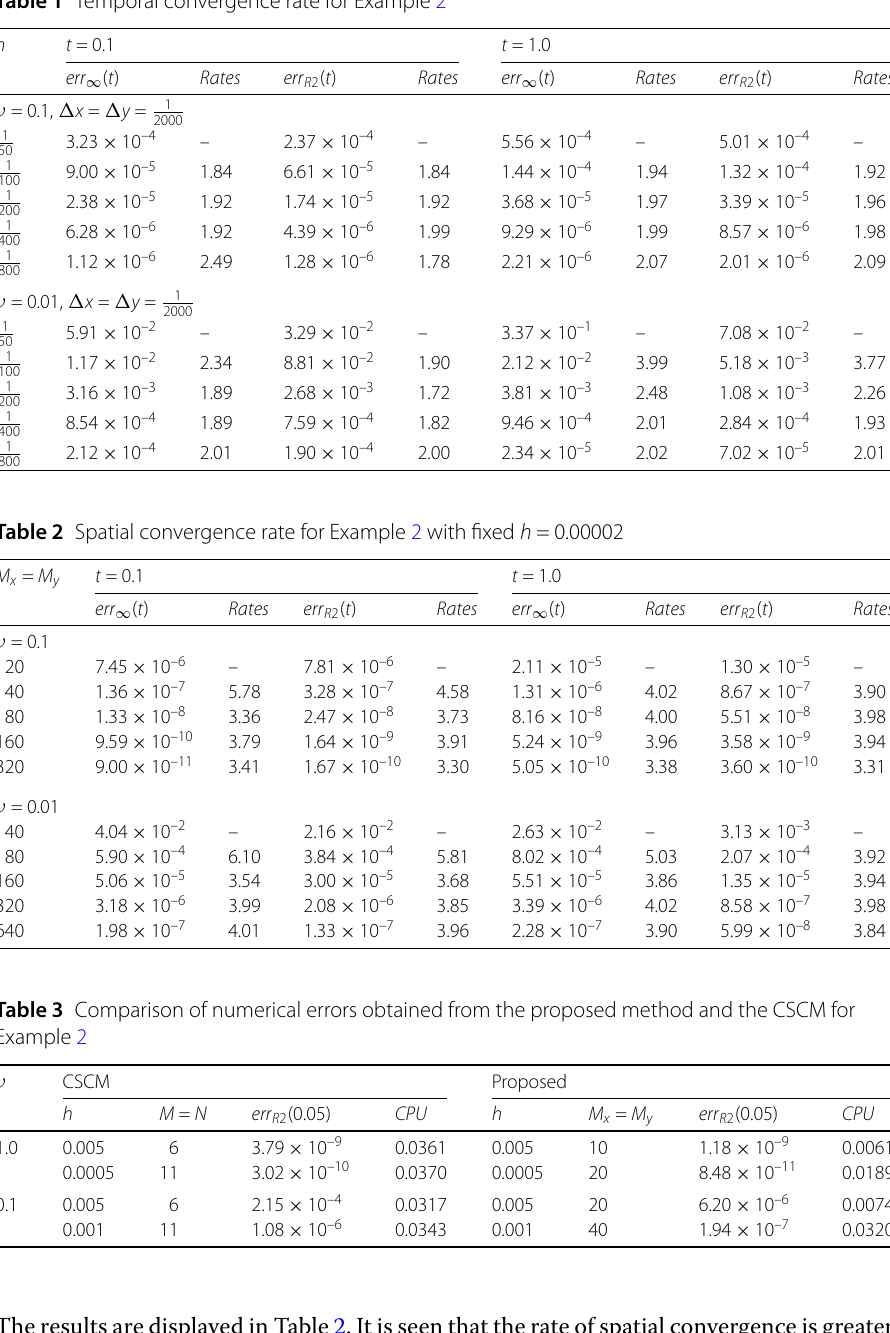
Table 1 Temporal convergence rate for Example 2